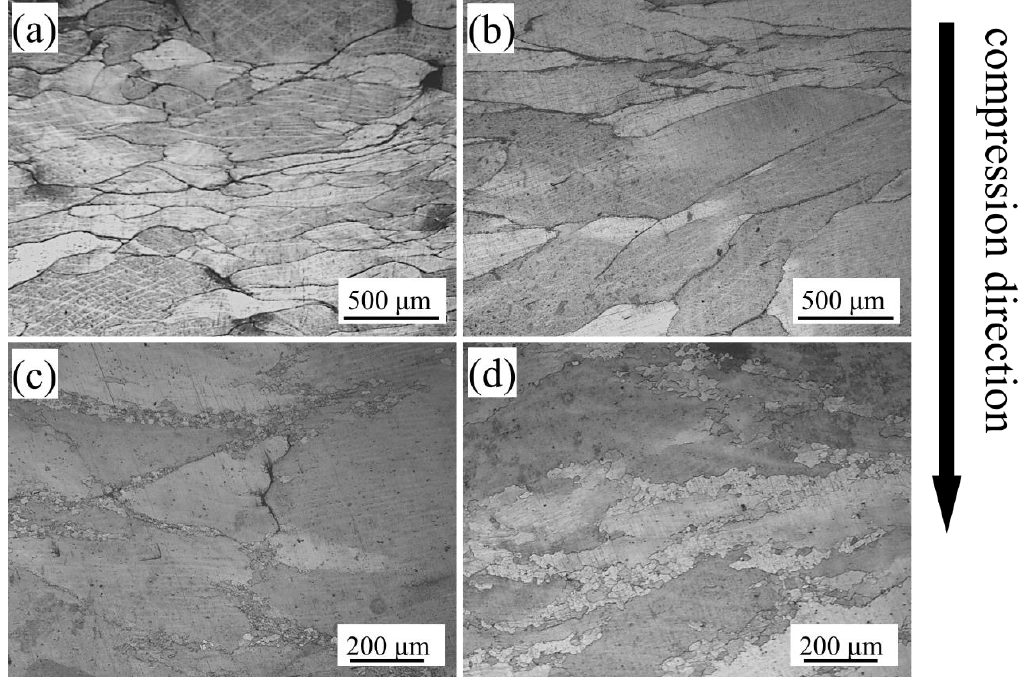
Figure 6. OM images of the alloy deformed at a strain rate of 0.01 s −1 under temperatures of ( a ) 720 °C, ( b ) 760 °C, ( c ) 840 °C, and ( d ) 880 °C.